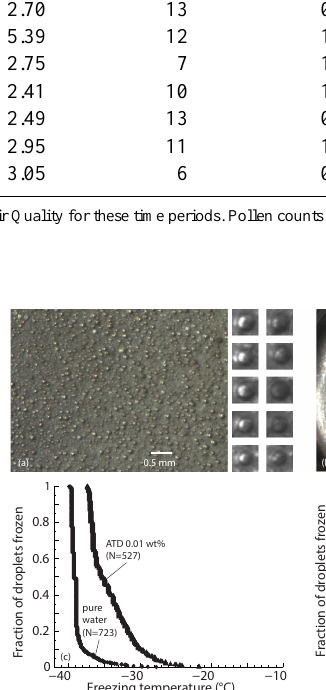
ated ultrapure water (18.2 M (cid:127) resistivity) and a suspension of 0.01 wt% of Arizona Test Dust (ATD) in ultrapure